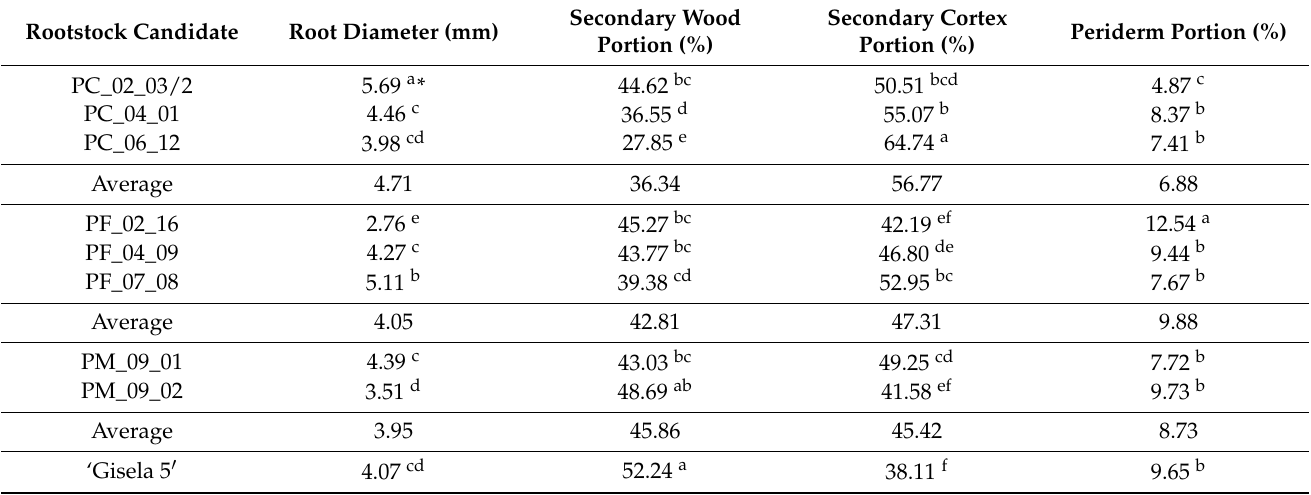
Table 1. Root cross-section anatomical characteristics of investigated cherry rootstocks, belonging to Prunus cerasus (PC), Prunus fruticosa (PF), Prunus mahaleb (PM) species and control ‘Gisela 5 (cid:48) .